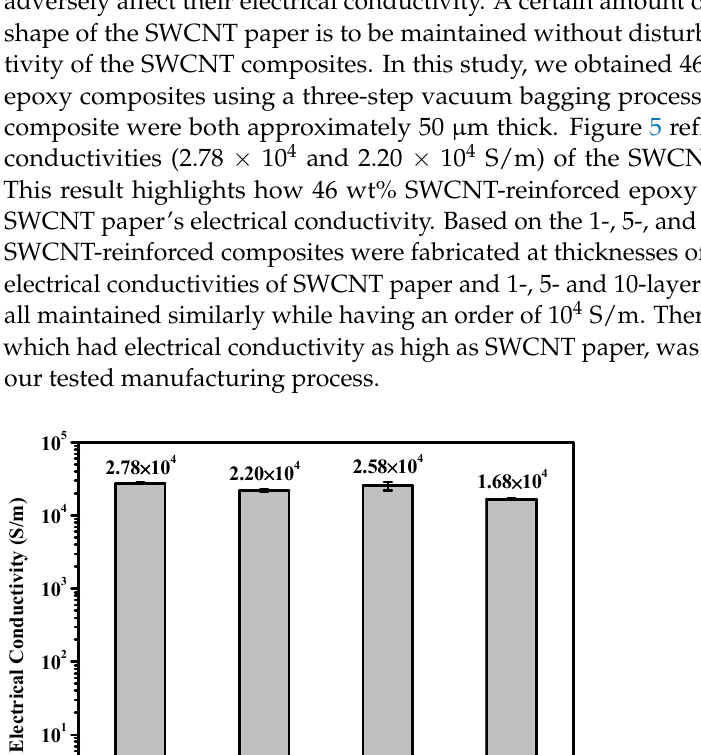
Figure 5. Electrical conductivity of SWCNT paper and stacked-layer composites.